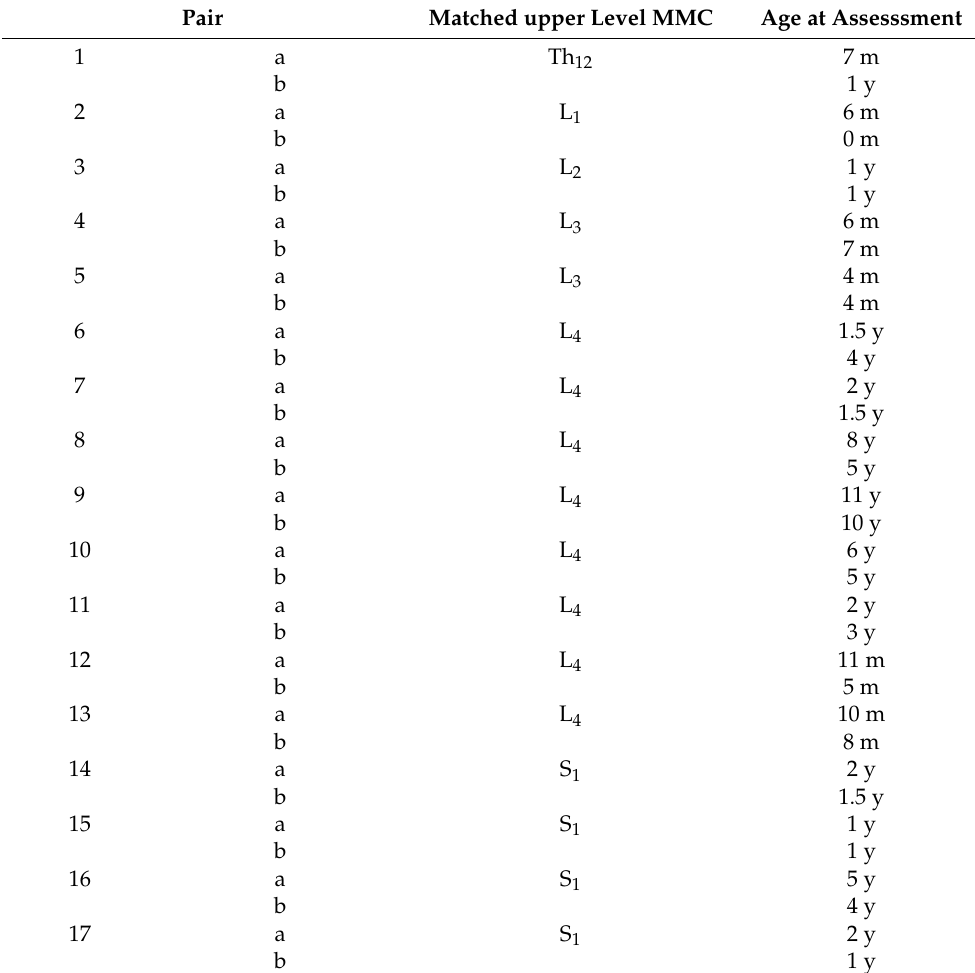
Table 1. Age- and MMC matched pairs: a. OSBAR versus b. NSBAR.